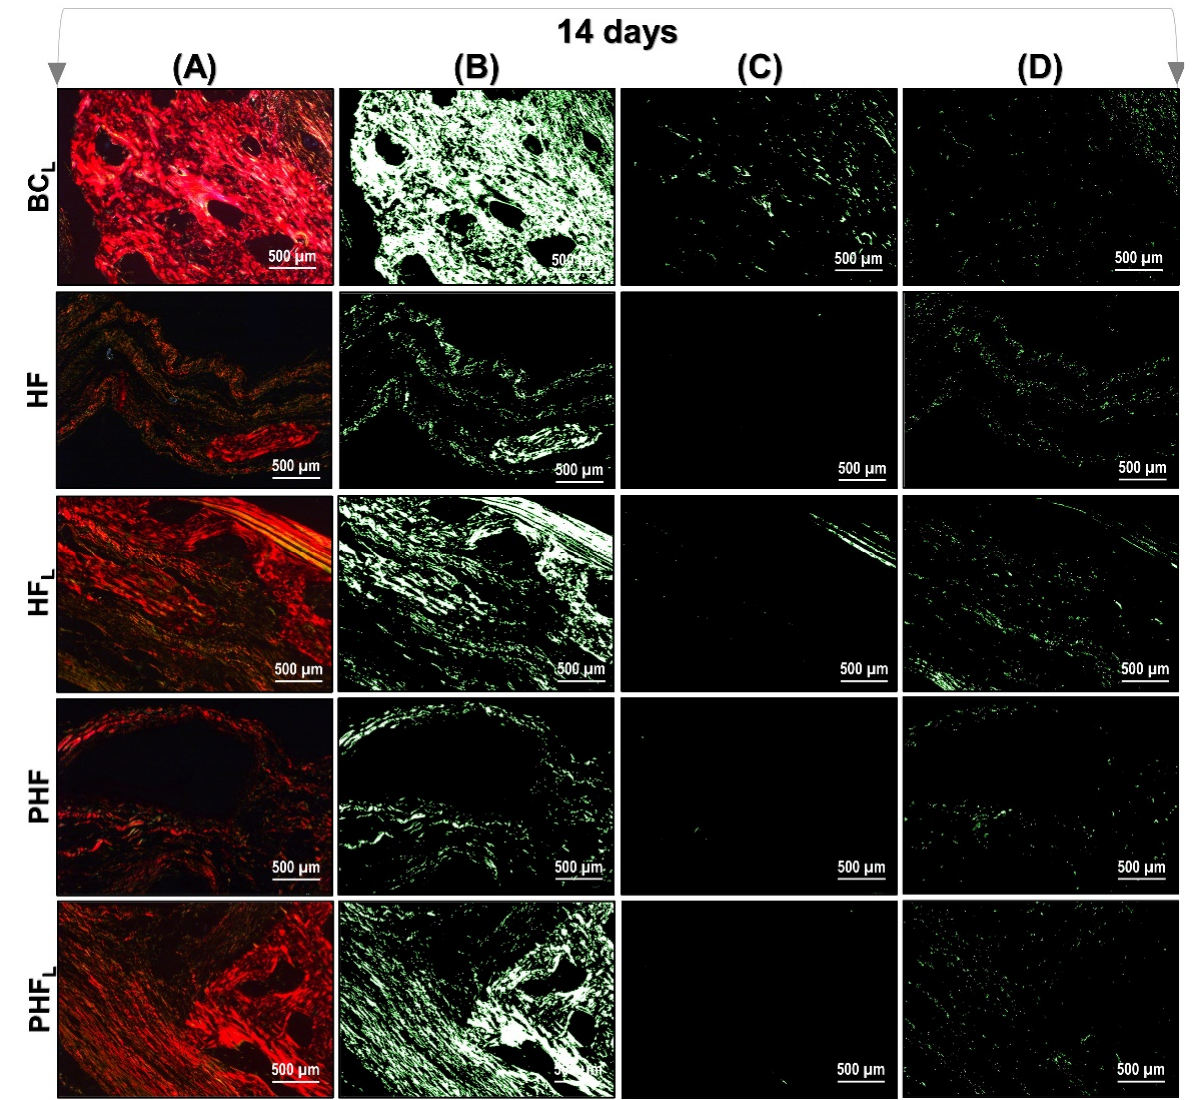
Figure 6. Images of Picrosirius-red stained sections observed by polarized light microscopy after 14 days. n = 12/group): BCL, HF, HFL, PHF and PHFL groups. ( A ) Polarized image showing the deposition of birefringent collagen (arrows); ( B ) Regions marked in red; ( C ) Regions marked in yellow corresponding to polarizing collagen deposition; ( D ) Regions marked in green. The yellowish–green birefringence of collagen fibers corresponds to thin bundles with diverse and disorganized arrangements, and reddish corresponds to dense and organized bundles, Picrosirius-red under polarization, 40× objective. Bars = 500 µm.